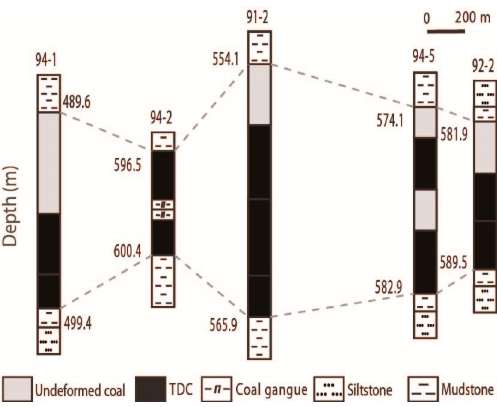
Figure 7. Geological section across wells of 94-1, 94-2, 91-2, 94-5, and 92-2.